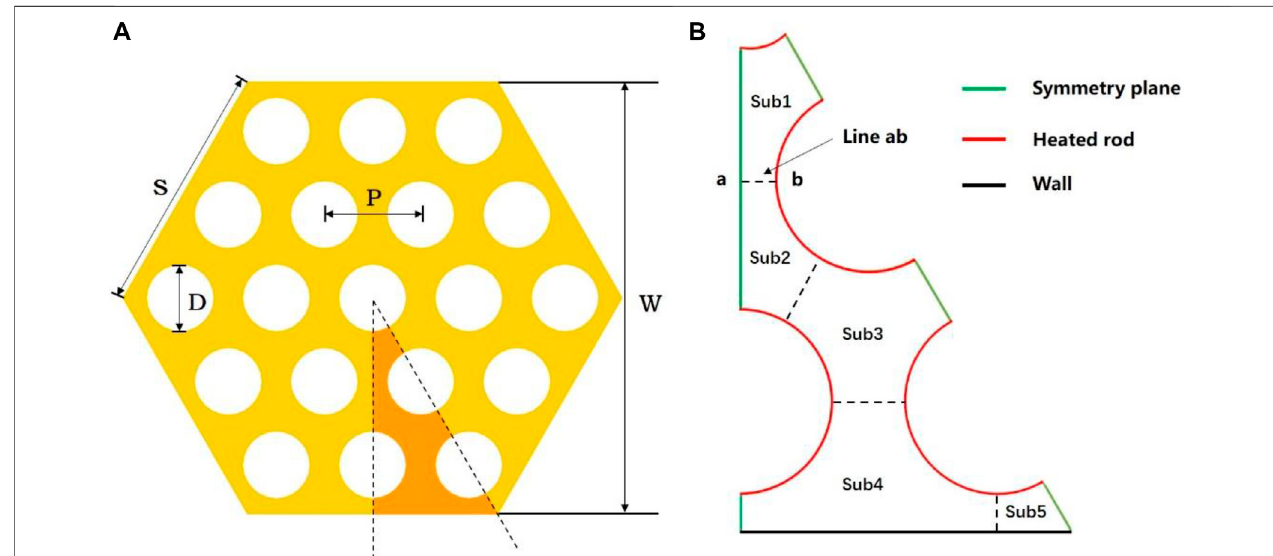
FIGURE 1 | Diagrammatic sketch of the bare 19-rod bundle. (A) Cross section and (B) computational domain.